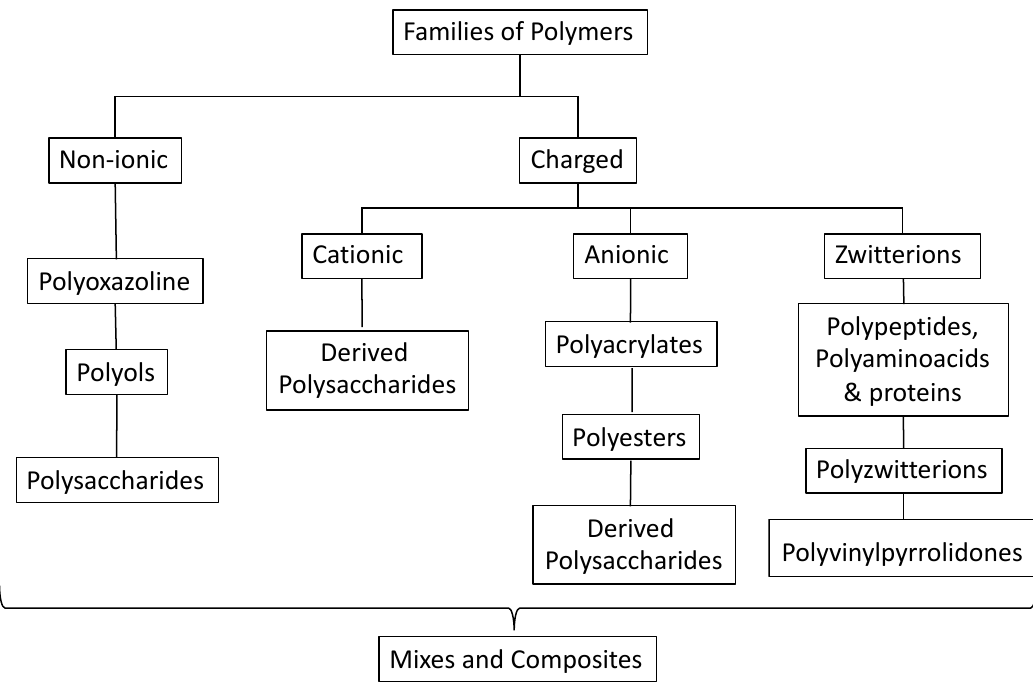
Figure 7. Polymer families for drug delivery systems of antioxidants for